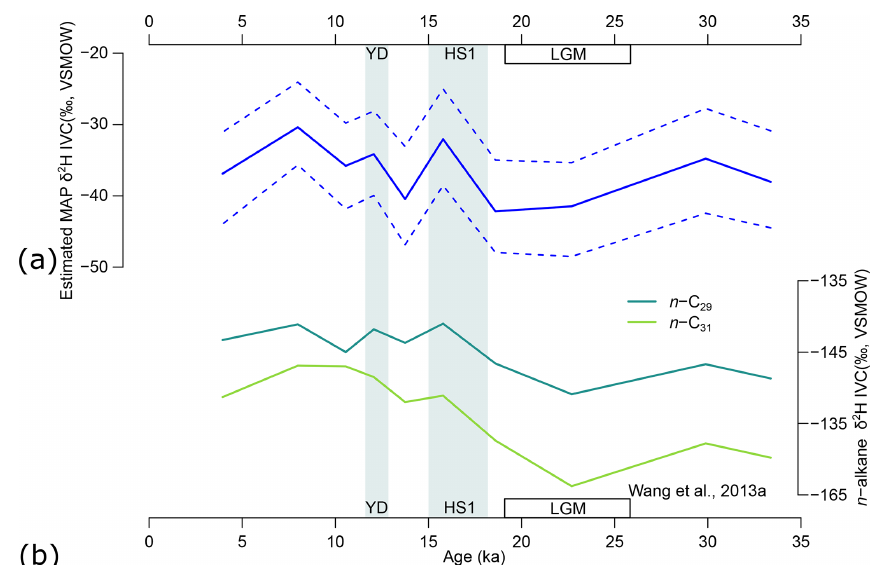
Figure 12. (a) Model estimates of mean annual precipitation δ 2 H based on n -alkane δ 2 H (ice-volume-corrected data, IVC), δ 13 C, and relative abundance of four n -alkane chains from the GIK 16160-3 core (Wang et al., 2013a). Solid lines represent maximum a posteriori estimates (MAPE) of the three sources. Horizontal dashed lines represent the 89% highest density interval (HDI) of the posterior distributions. (b) The δ 2 H (IVC) of n -C 29 and n -C 31 chains reported by Wang et al. (2013a) for reference. YD represents the Younger Dryas ( ∼ 13–11ka). HS1 represents Heinrich Stadial 1 ( ∼ 18–15ka). LGM represents the Last Glacial Maximum ( ∼ 26–19ka).